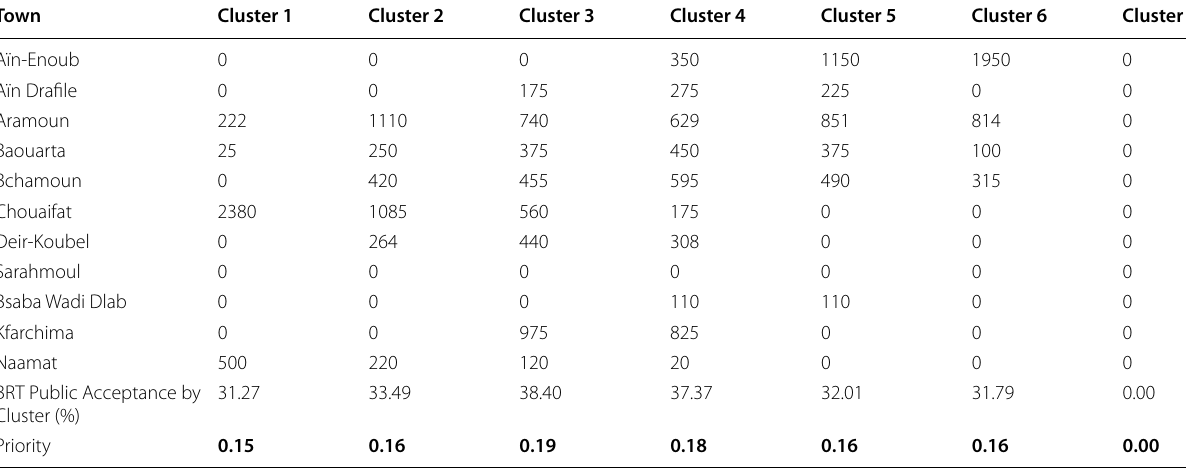
Table 9 Public acceptance rate of the